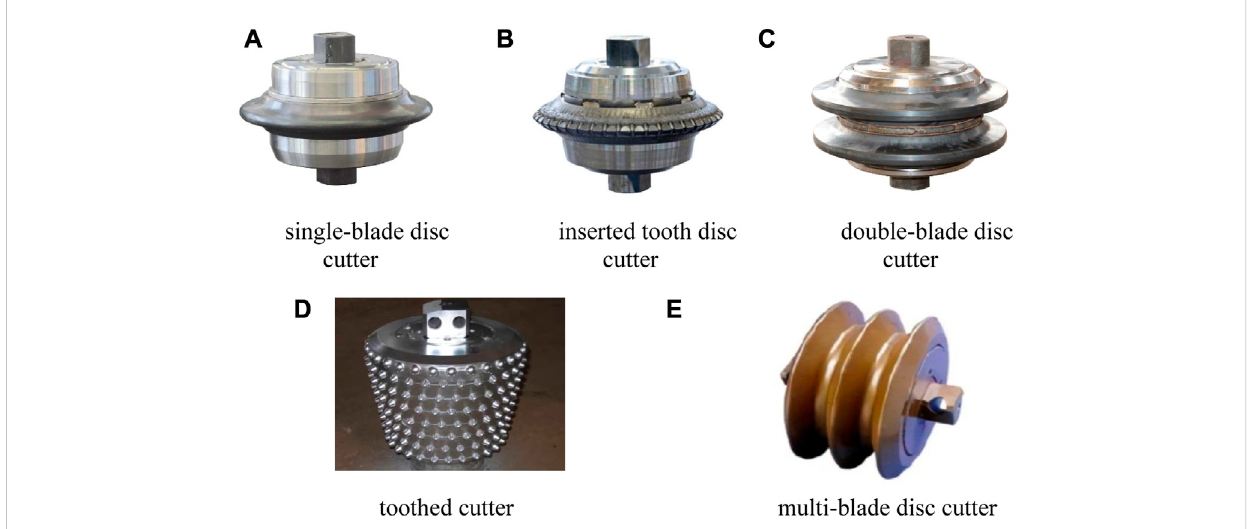
FIGURE 1 CommontypesoftheTBMrollingcutter (A) single-blade disccutter (B) insertedtoothdisccutter (C) double-bladedisccutter (D) toothedcutter (E) multi-blade disc cutter.